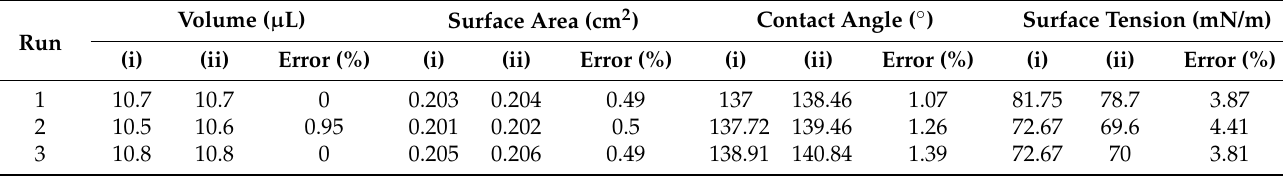
Figure 3. ( a ) – ( c ) Images of 10 μL droplet s with constructed fitting curves using ImageJ’s plugin LBADSA . Scale bar is Figure 3. ( a – c ) Images of 10 µ L droplets with constructed fitting curves using ImageJ’s plugin LBADSA. Scale bar is 1 mm. 1mm. Table 4. Comparison of droplet parameters between two methods: (i) LBADSA; (ii) axisymmetrical elliptic